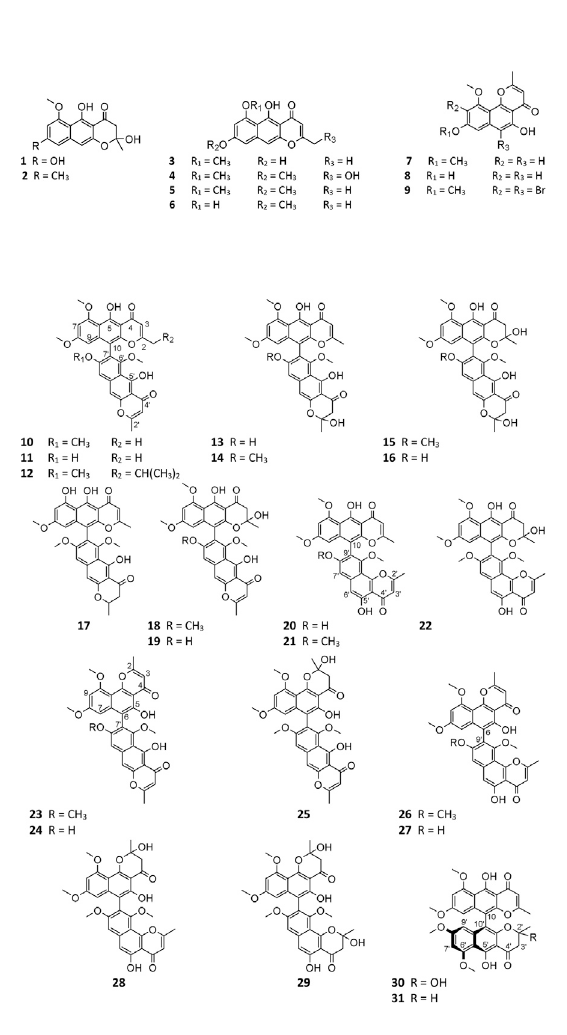
(Sakurai et al., 2002; Zhang et al., 2007b). One new cytotoxic and antimicrobial rubrofusarin B ( 5 ) was puri fi ed from strain IFB- E003 endophytic on Cynodon dactylon Linn. (Song et al., 2004). When cultivated in NaBr or CaBr 2 -containing medium, one